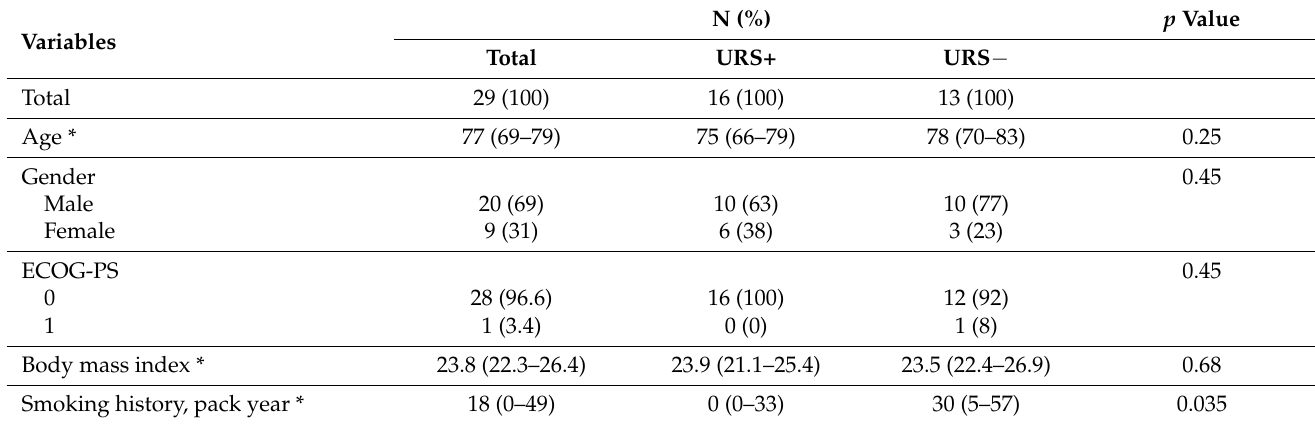
Figure 2. Demographics according to tumor architecture and pathological tumor stage ( A ) and Kaplan–Meier curves for overall survival (OS) and progression-free survival (PFS) according to whether or not a ureterorenoscopy (URS) was performed before radical nephroureterectomy in subgroups of patients with non-papillary upper tract urothelial carcinoma and ≥ pT3 ( B ) disease, papillary and ≥ pT3 ( C ) disease, non-papillary and ≤ pT2 disease ( D ), and papillary and ≤ pT2 disease ( E ). B to E in Panel ( A ) correspond to Panels ( B – E ), respectively. Table 4. Demographics of 29 upper tract urothelial carcinoma patients with ≥ pT3 and non-papillary archi- tecture according to whether or not ureterorenoscopy was performed prior to radical